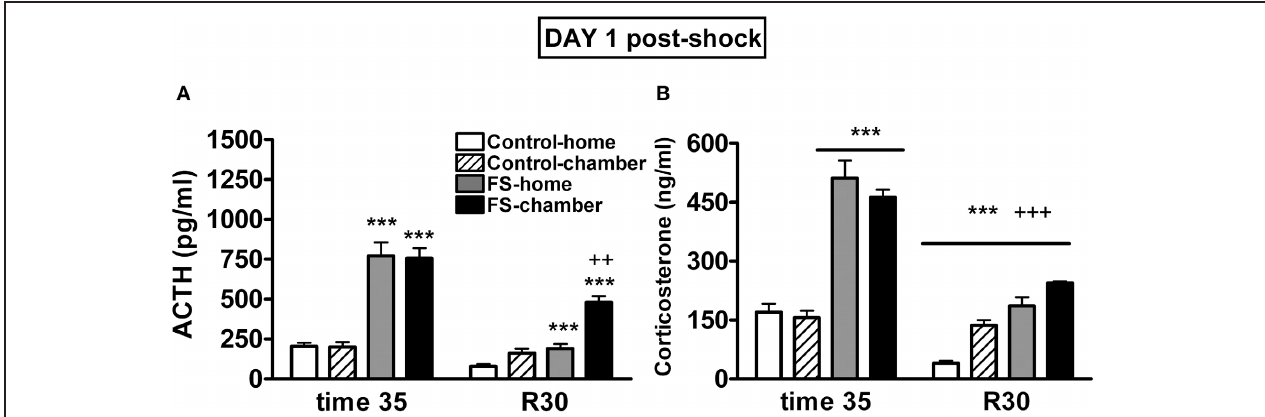
FIGURE 3 | Plasma ACTH (A) and corticosterone (B) levels on day 1 for Experiment 1. Means and SEM are represented. The groups were as follows: control-home, not shocked during the 35min exposure to the shock chamber and returned to the home-cage after that; control-chamber, not shocked during the 35min in the chamber and maintained in the shock chamber for an additional period of 30min (R 0–30); FS-home, shocked in